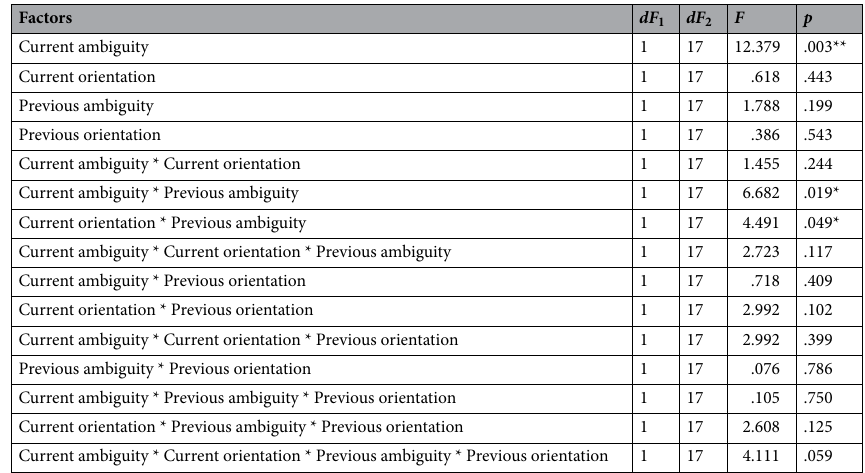
Table 2. Percentage of correct responses on the current stimulus, CR [%] (ANOVA Summary).